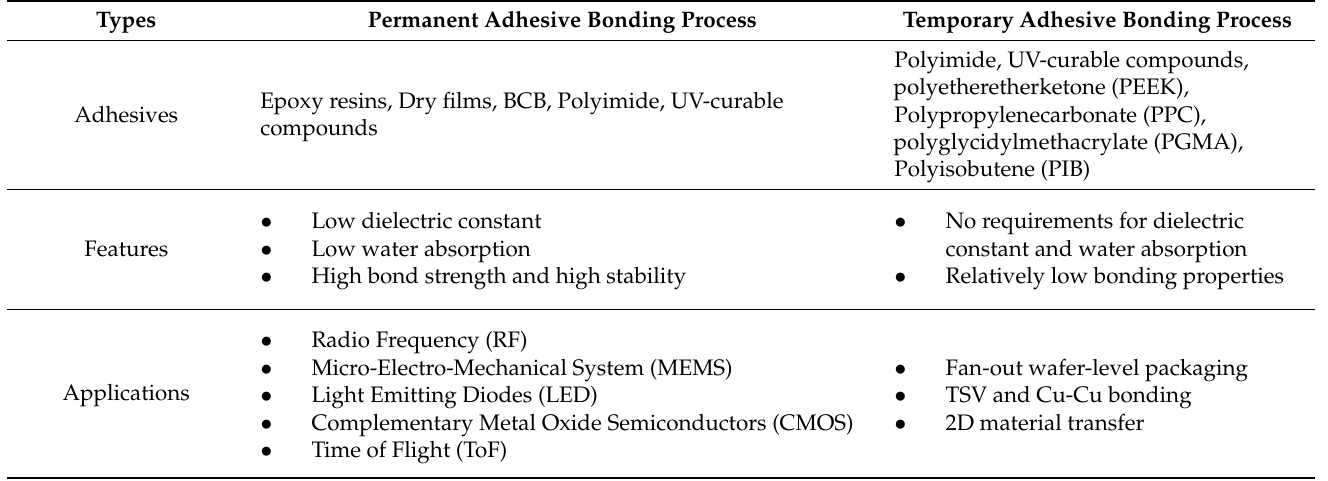
Table 1. Comparison of permanent adhesive bonding and temporary adhesive